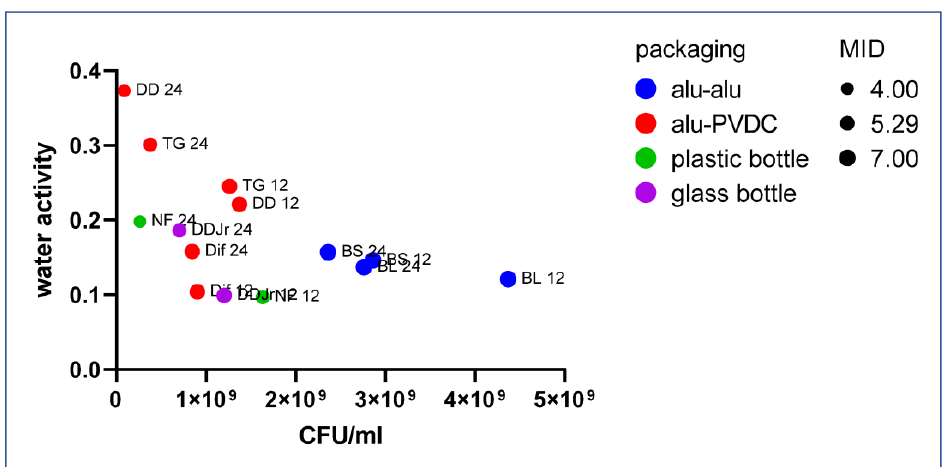
Figure 3. Principal component analysis (PCA) of the probiotic products at 12 and 24 months after manufacture (AM). BL = Bactoblis Lozenge; BS = Bactoblis Sachets; DD = Daily Defence; DDJr = Daily Defence Junior; Dif = Difflam; TG = Throat Guard PRO; NF = Now Foods Oral Biotics. The numbers (12/24) indicate the time of testing, namely, 12/24 months AM.